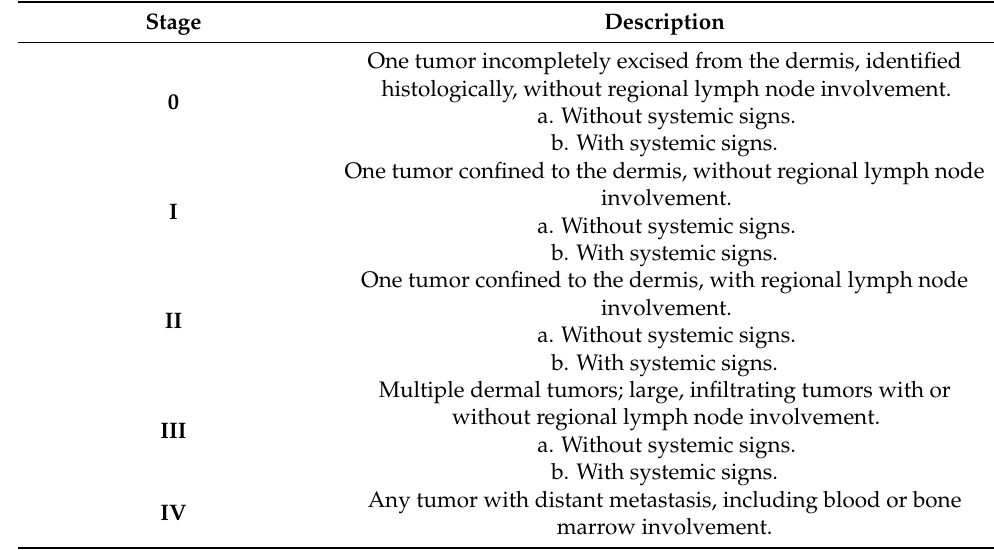
Table 1. Clinical Staging System for Canine Cutaneous MCT proposed by the WHO.